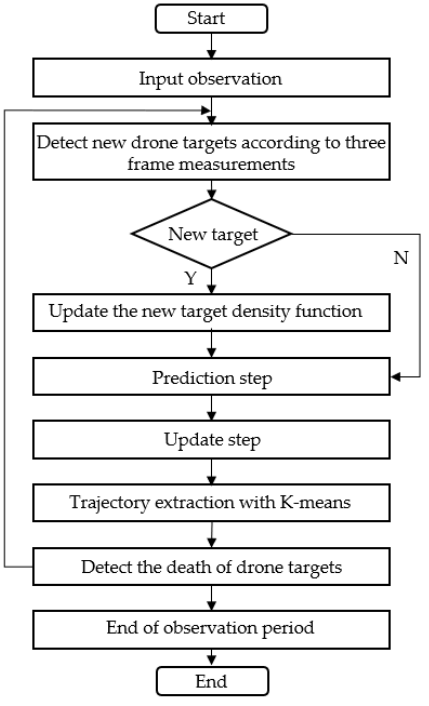
Figure 2. Overall block diagram of the DGM-PHD filter.